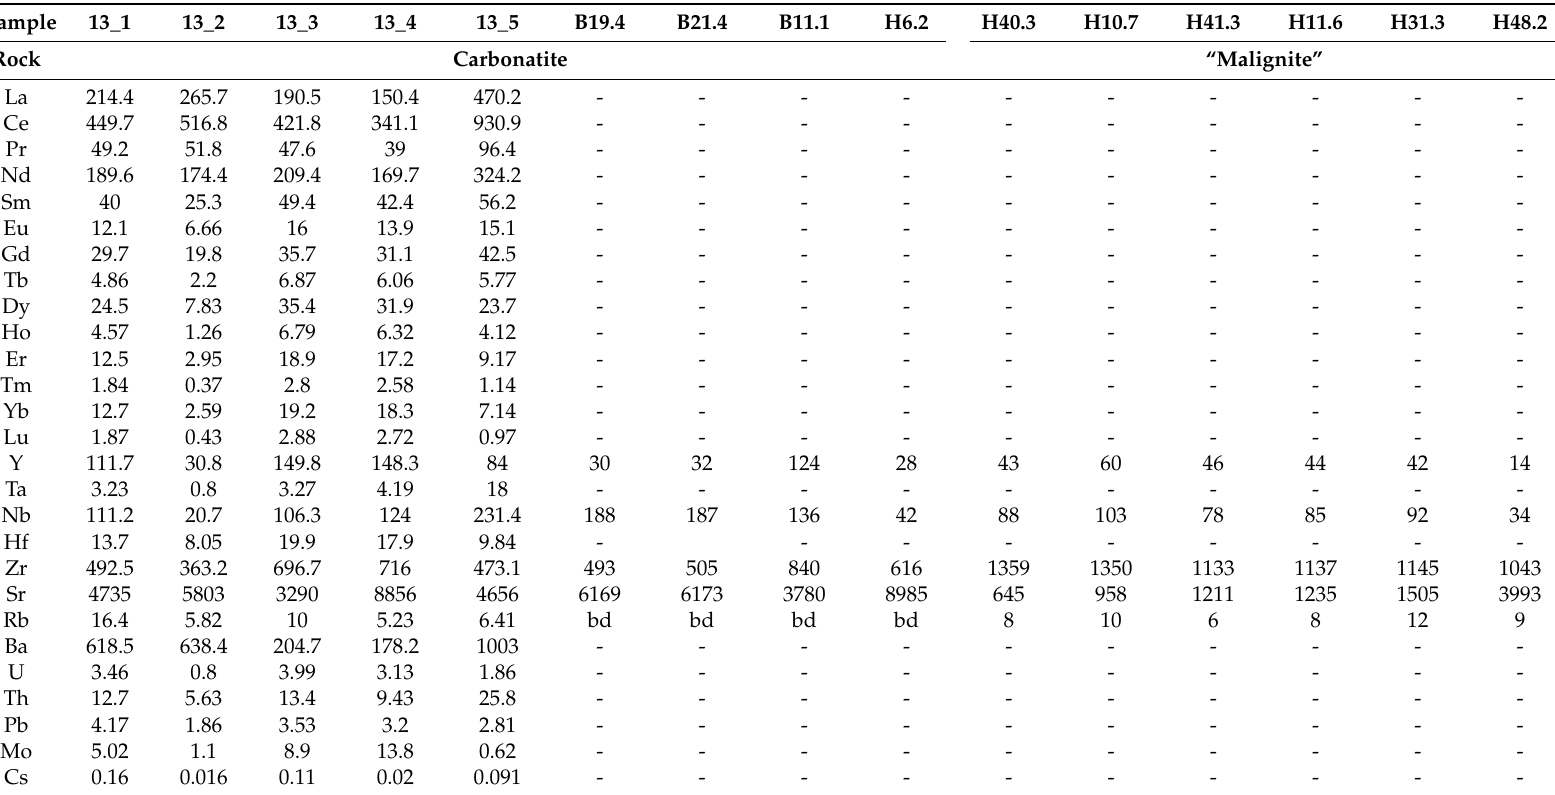
Table 6. Representative trace elements and REE analyses of the Breivikbotn carbonatite and alkaline rocks